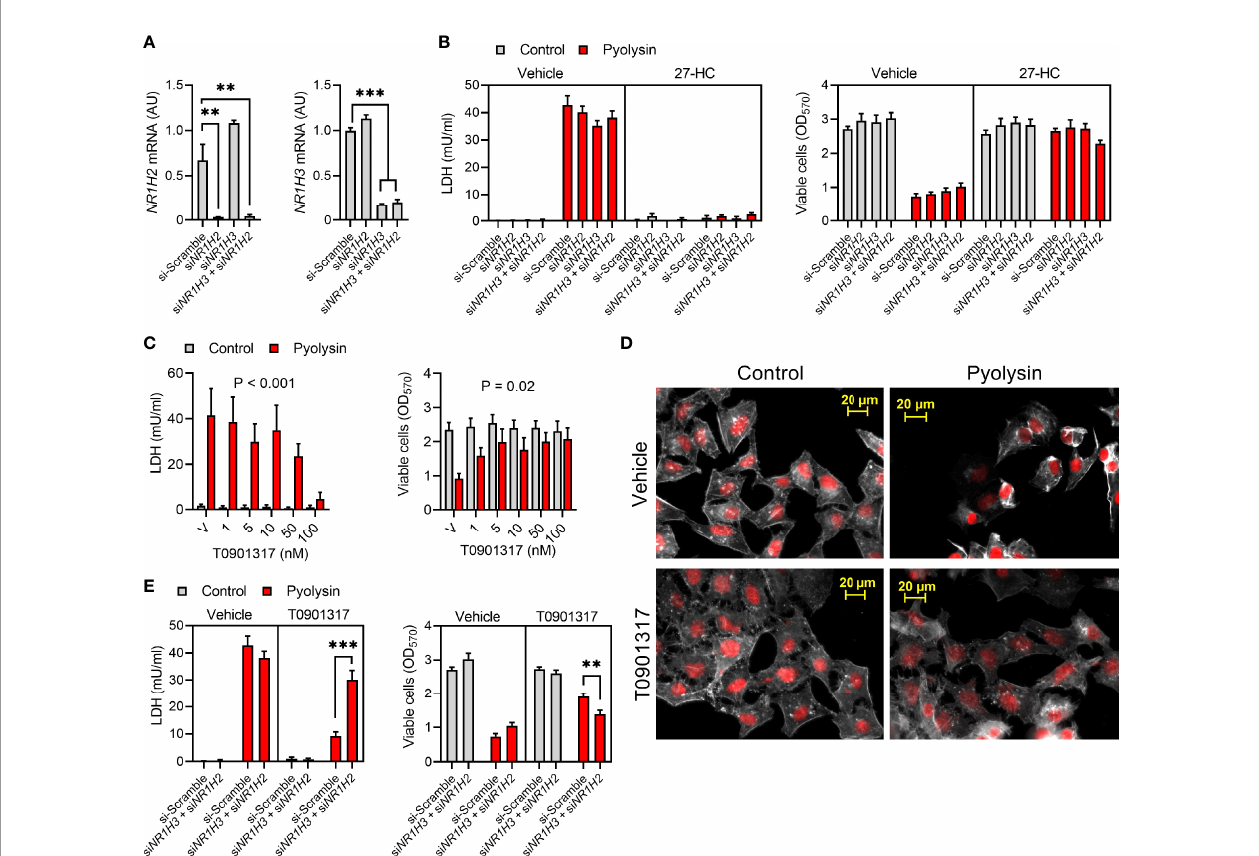
FIGURE 6 | Liver X receptors are not required for 27-hydroxycholesterol cytoprotection. (A) Normalized NR1H2 and NR1H3 mRNA expression measured by qPCR for HeLa cells transfected with scramble siRNA or siRNA targeting NR1H3 , NR1H2 , or both NR1H3 and NR1H2 . Data are presented as mean + s.e.m. from 3 independent experiments; data were analyzed by ANOVA with Dunnett ’ s post hoc test, ***P < 0.001, **P < 0.01. (B) HeLa cells were transfected for 48 h with scramble siRNA or siRNA targeting NR1H3 , NR1H2 , or both NR1H3 and NR1H2 ; cultured for 24 h in medium with vehicle or 10 ng/ml 27-hydroxycholesterol (27- HC); and, then challenged for 2 h with control serum-free medium ( ■ ) or 100 HU pyolysin ( ■ ). Leakage of LDH was measured in cell supernatants, and viable cells were determined by MTT assay. Data are presented as mean + s.e.m. from 4 independent experiments. (C) HeLa cells were cultured for 24 h in serum-free medium with vehicle (V) or the indicated concentrations of T0901317, and then challenged for 2 h with control serum-free medium ( ■ ) or 100 HU pyolysin ( ■ ). The leakage of LDH was measured in cell supernatants and viable cells were determined by MTT assay. Data are presented as mean + s.e.m. from 4 independent experiments; data were analyzed by ANOVA and P values reported for the treatment effect on pyolysin challenge. (D) Fluorescent microscope images of HeLa cells cultured for 24 h in serum-free medium with vehicle or 50 nM T0901317, and then challenged for 2 h with control medium or 100 HU pyolysin. Cells were stained with Alexa Fluor 555-conjugated phalloidin to visualize F-actin (white) and fl uorescent microscope images collected (nuclei are red); images are representative of 3 experiments. (E) HeLa cells were transfected for 48 h with scramble siRNA or siRNA targeting both NR1H3 and NR1H2 ; cultured for 24 h in medium with vehicle or 50 nM T0901317; and, then challenged for 2 h with control serum-free medium ( ■ ) or 100 HU pyolysin ( ■ ). Leakage of LDH was measured in cell supernatants, and viable cells were determined by MTT assay. Data are presented as mean + s.e.m. from 4 independent experiments; statistical signi fi cance was determined by ANOVA and Tukey ’ s post hoc test, ***P < 0.001, **P <